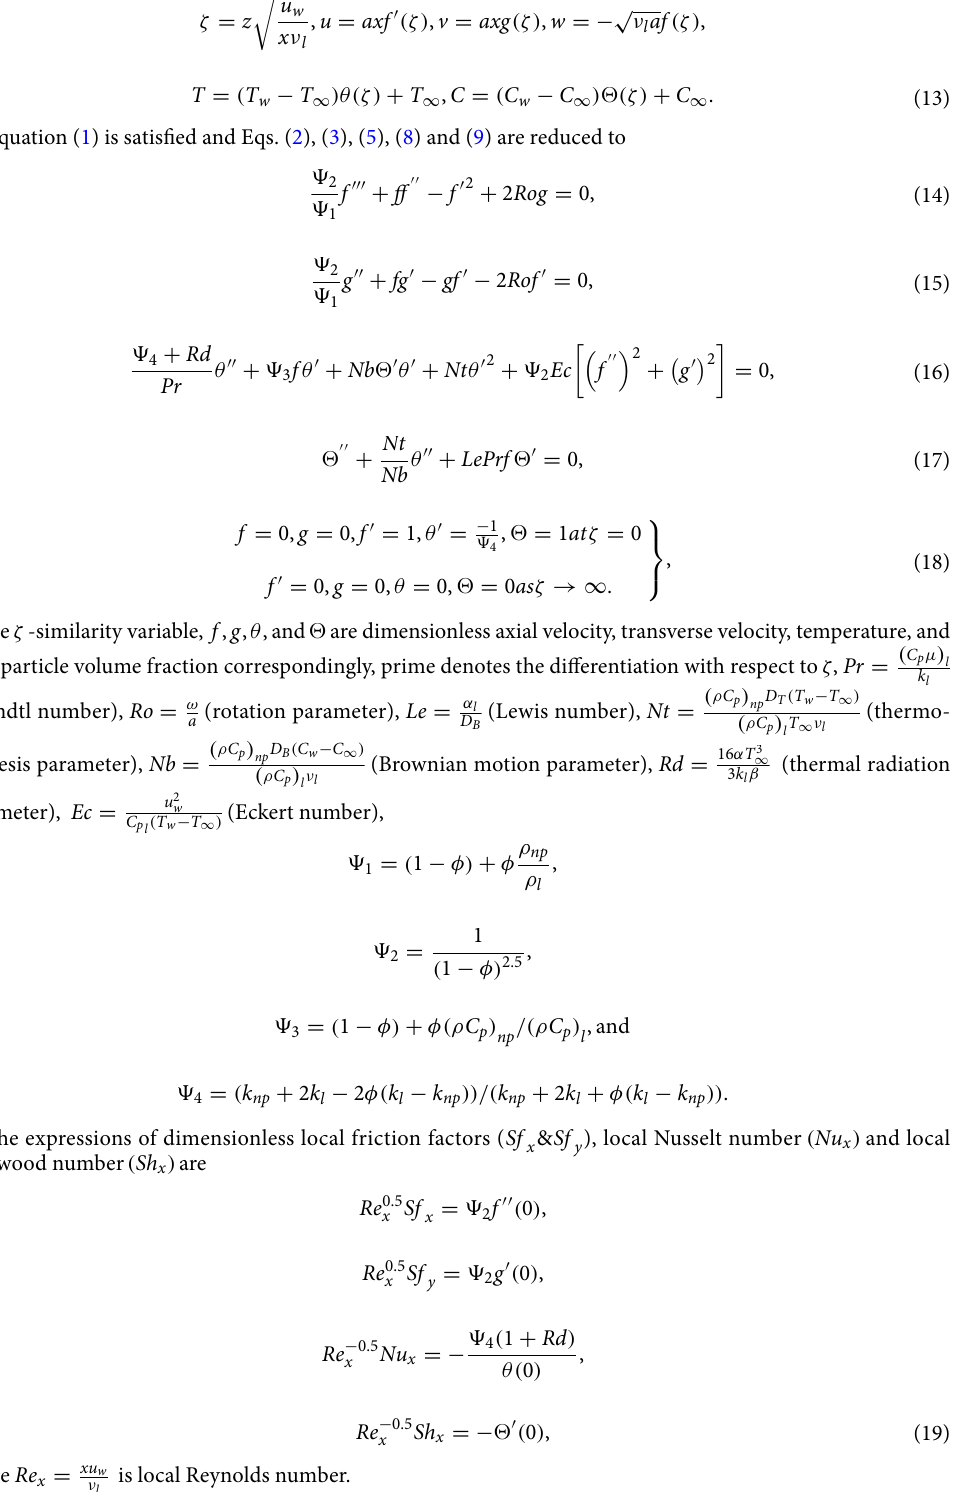
xu w where Re x ν l is local Reynolds =